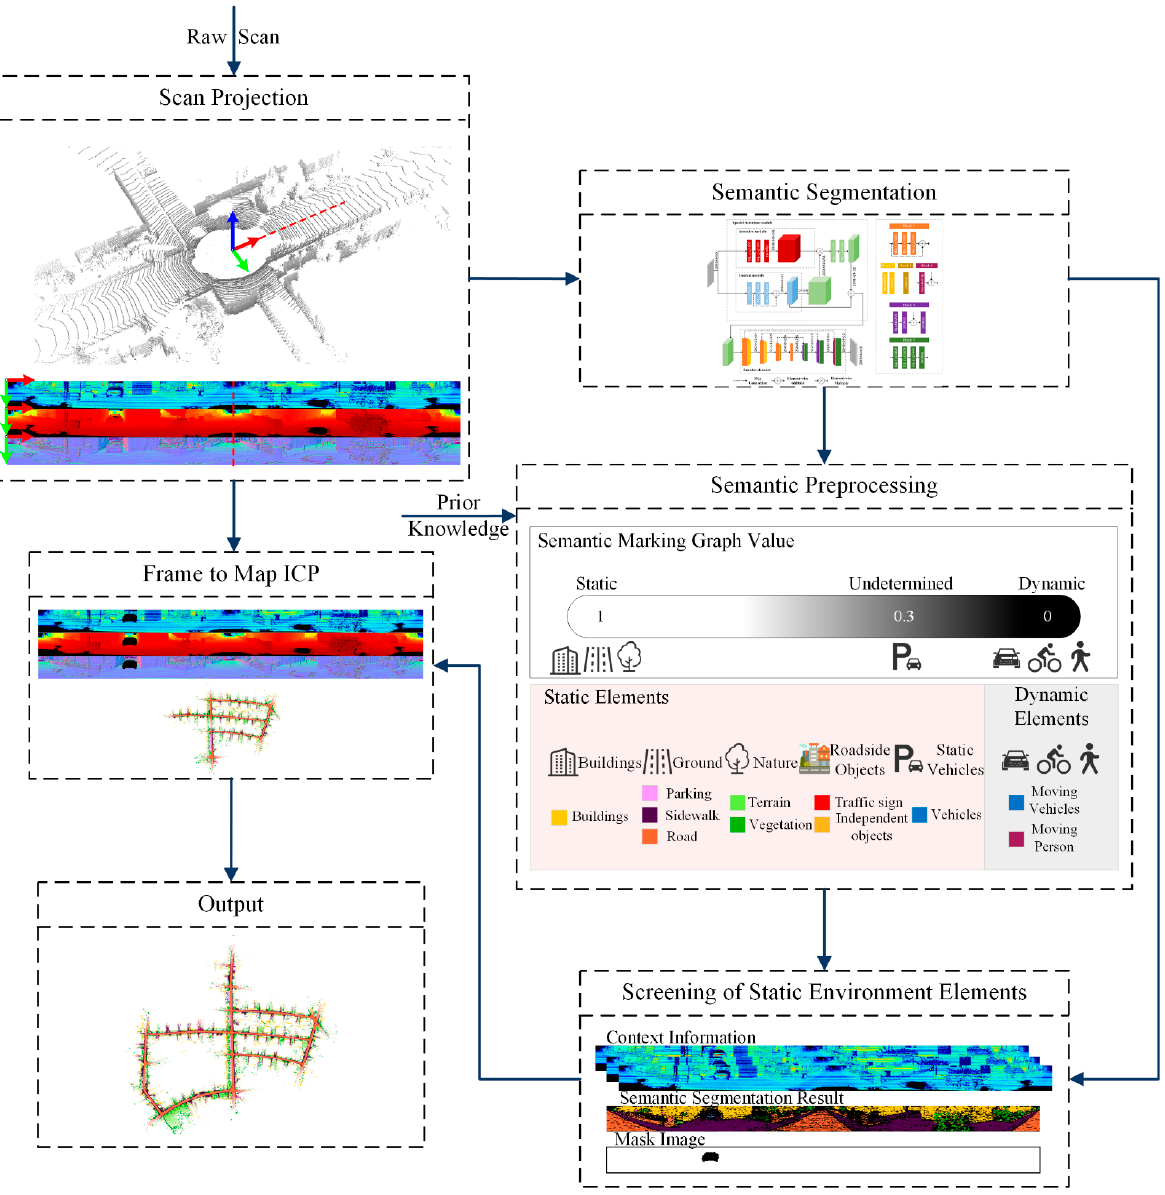
Figure 3. Overview of our proposed method. Input scans are projected through spherical projection and segmented by proposed SANet, then elements that fall in the assumed dynamic content by semantic pre-processing and screening algorithms are discarded for pose estimation. The static environment elements are fed into the SLAM algorithm for tracking and semantic mapping after dynamic feature points are discarded.